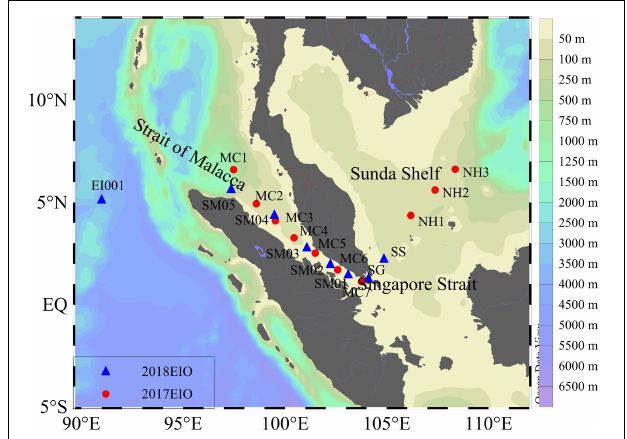
FIGURE 1 | Sampling stations designed in the Strait of Malacca. Two kinds of symbols in the legend represent two